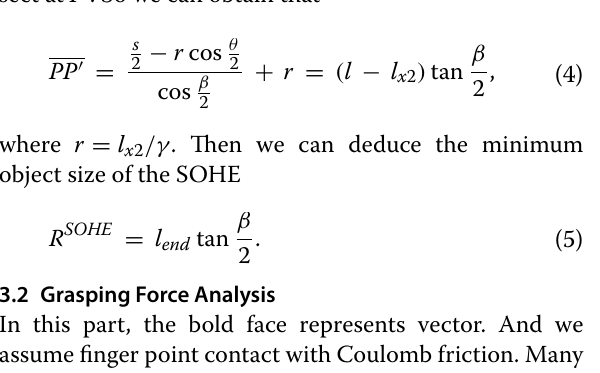
Figure 5 Grasping schematic diagram of BOHE and SOHE